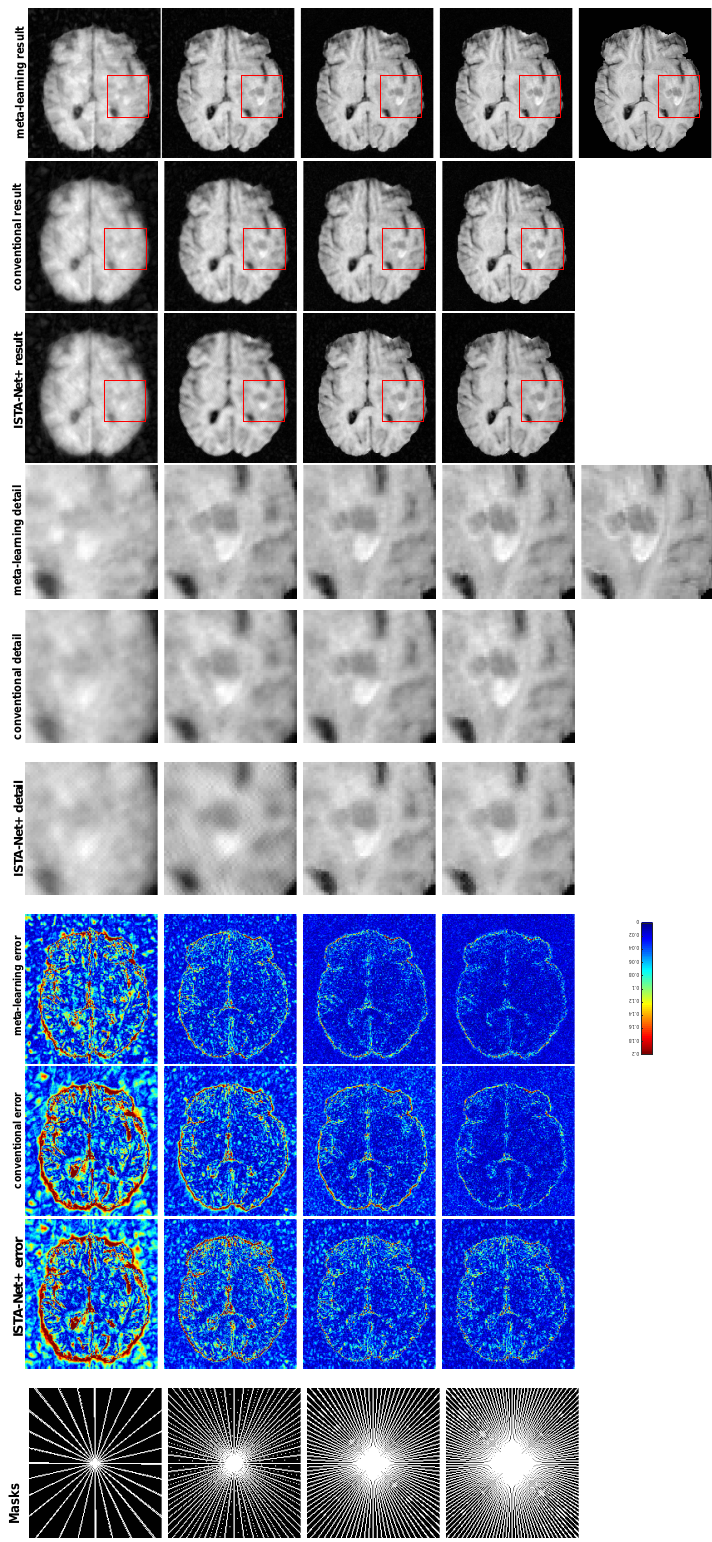
Figure 1. The pictures (from top to bottom) display the reconstruction results, zoomed-in details, point-wise errors with a color bar, and associated radial masks for meta-learning, conventional learning, and ISTA-Net + with four different CS ratios of 10%, 20%, 30%, 40% (from left to right). The top-right image is the ground truth fully-sampled image.